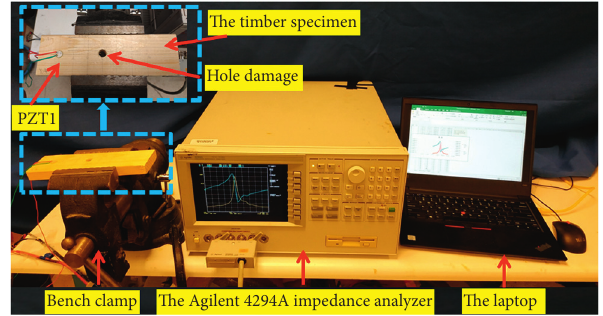
Figure 5: Experimental